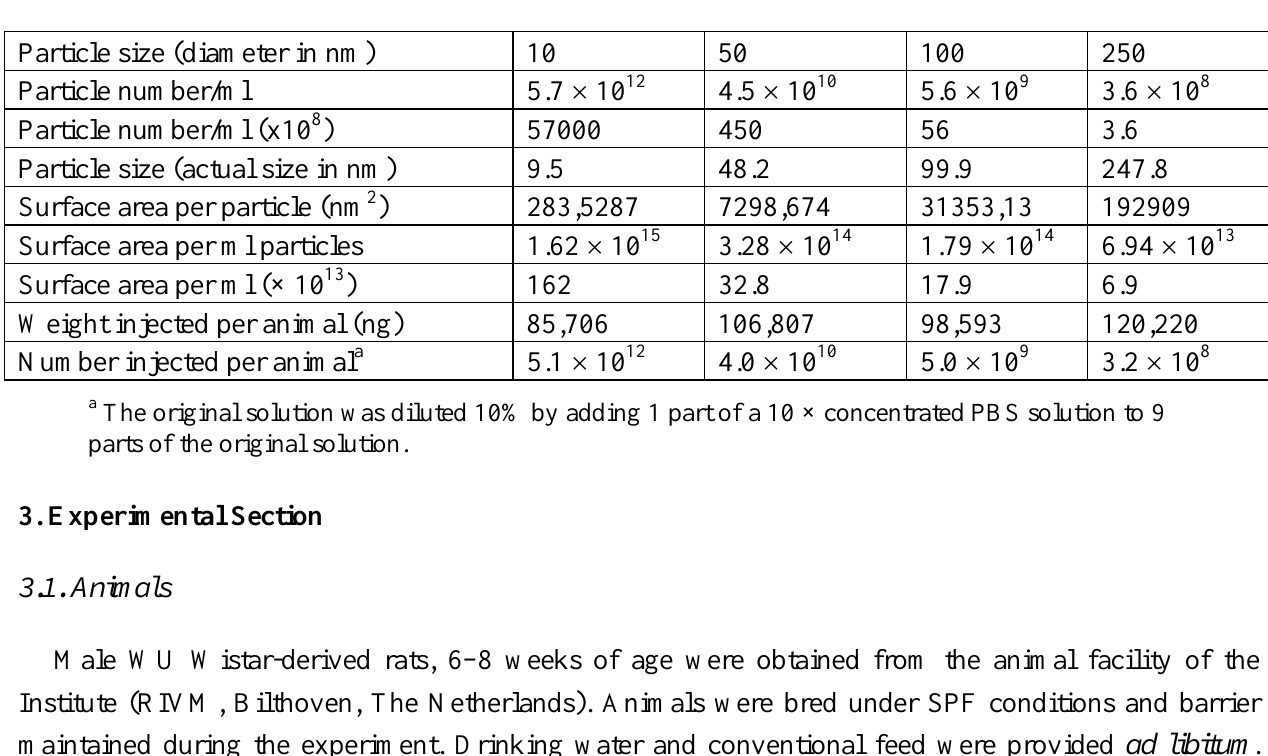
Table 1. Gold Nanoparticle